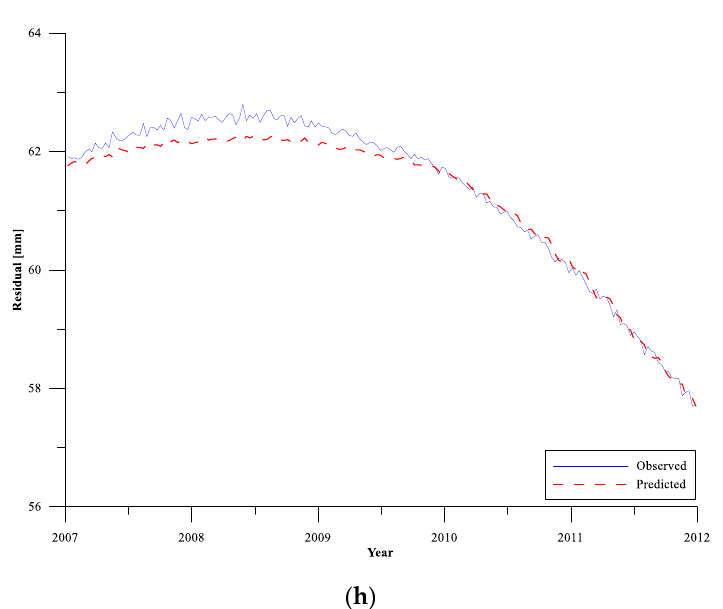
Figure 4. Comparison of predictions of IMF components by CEEMD decomposition for training period with optimal RBF network (Panels ( a – g ) represent the IMFs with cycles respectively, Panel ( h ) represents the residual.).